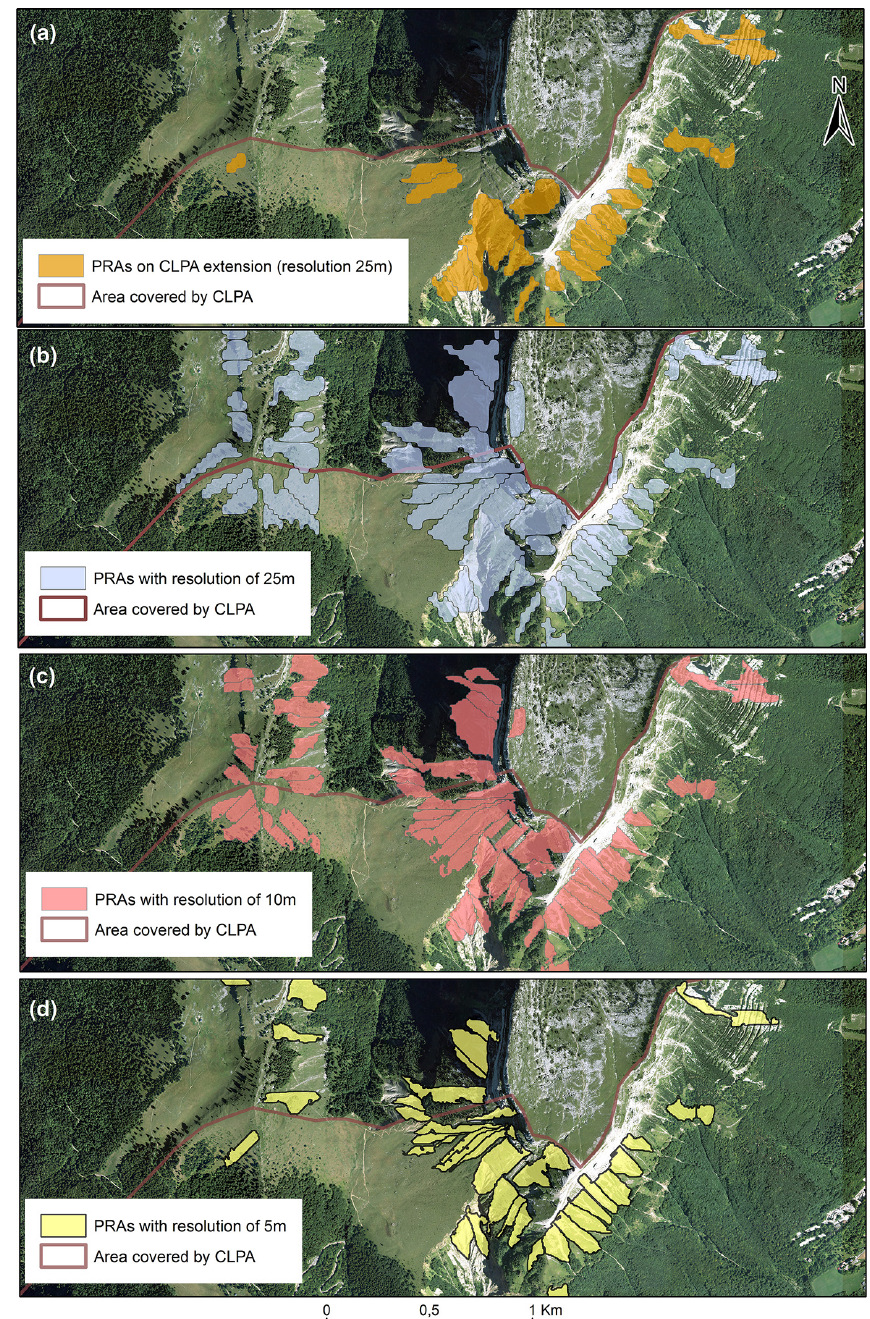
Figure 11. Effect of DEM resolution on PRA detection, Chartreuse/Dent de Crolles study area. Aerial photograph © IGN 2012. (a) For the determination of the validation sample, all factors and the DEM resolution are set to their default values (Fig. 4) and forest cover data are from DB forest IGN; the absence of CLPA in the upper-left corner is clearly visible. (b–d) For the PRA detection, DEM resolution varies, other factors are set to their default values (Fig. 3), and forest cover data are from DB forest IGN. In (a) , “CLPA extension” refers to avalanche extents from the French avalanche